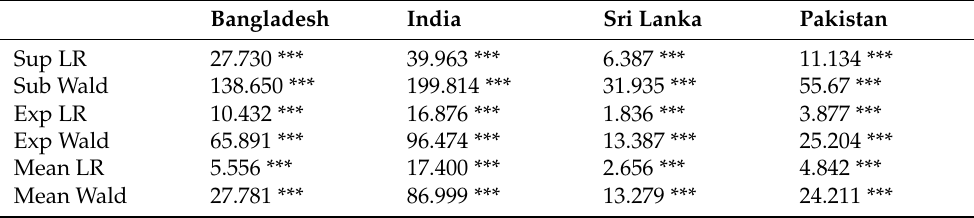
Table A1. The parameter instability test results.